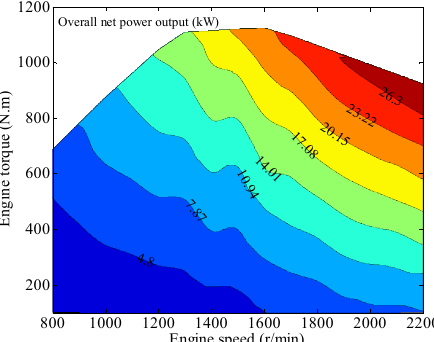
Figure 12. The distribution map of the net power output of the DORC